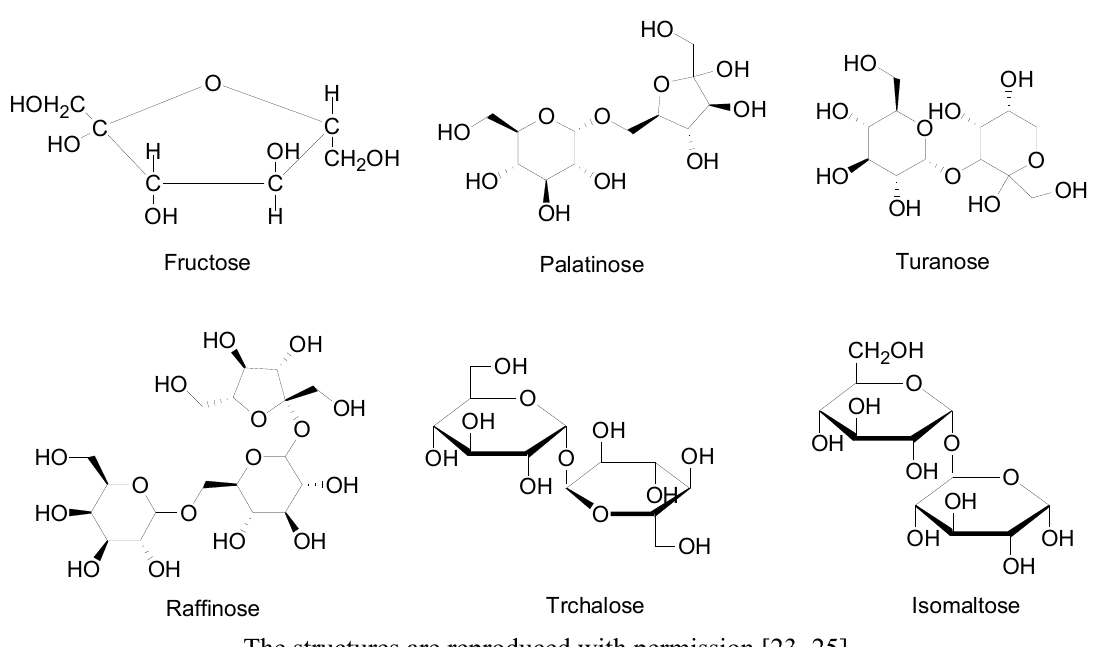
Figure 1. Molecular structures of fructose and oligosaccharides present in